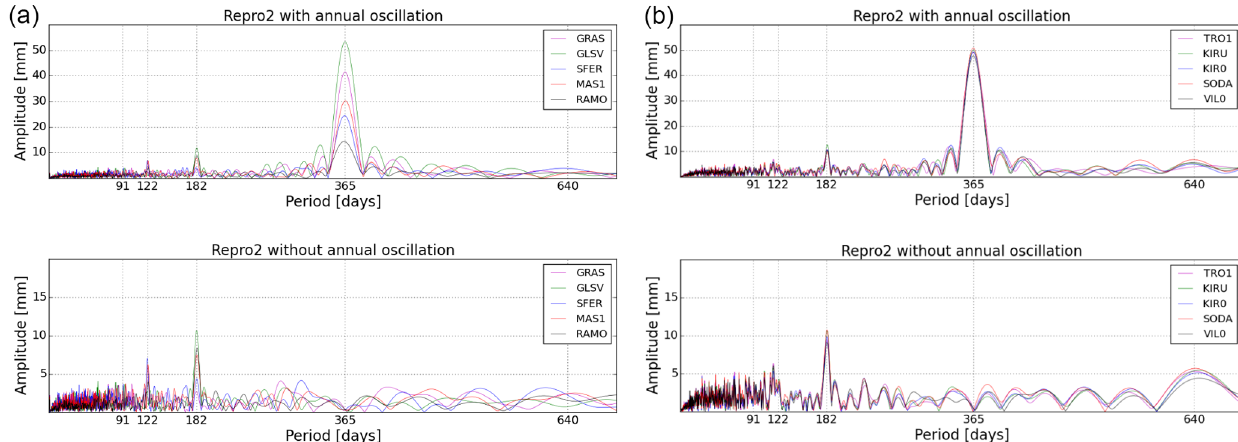
Figure 2. (a) Lomb–Scargle periodograms for GRAS, GLSV, SFER, MAS1 and RAMO stations with the annual oscillation (top) and without it (bottom); (b) Lomb–Scargle periodograms for TRO1, KIRU, KIR0, SODA and VIL0 stations with the annual oscillation (top) and without it (bottom), based on the Repro2